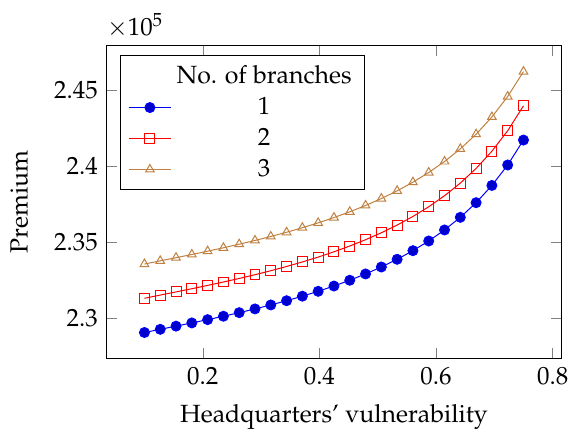
Figure 12. Impact of the intrinsic vulnerability on the premium in the limited liability